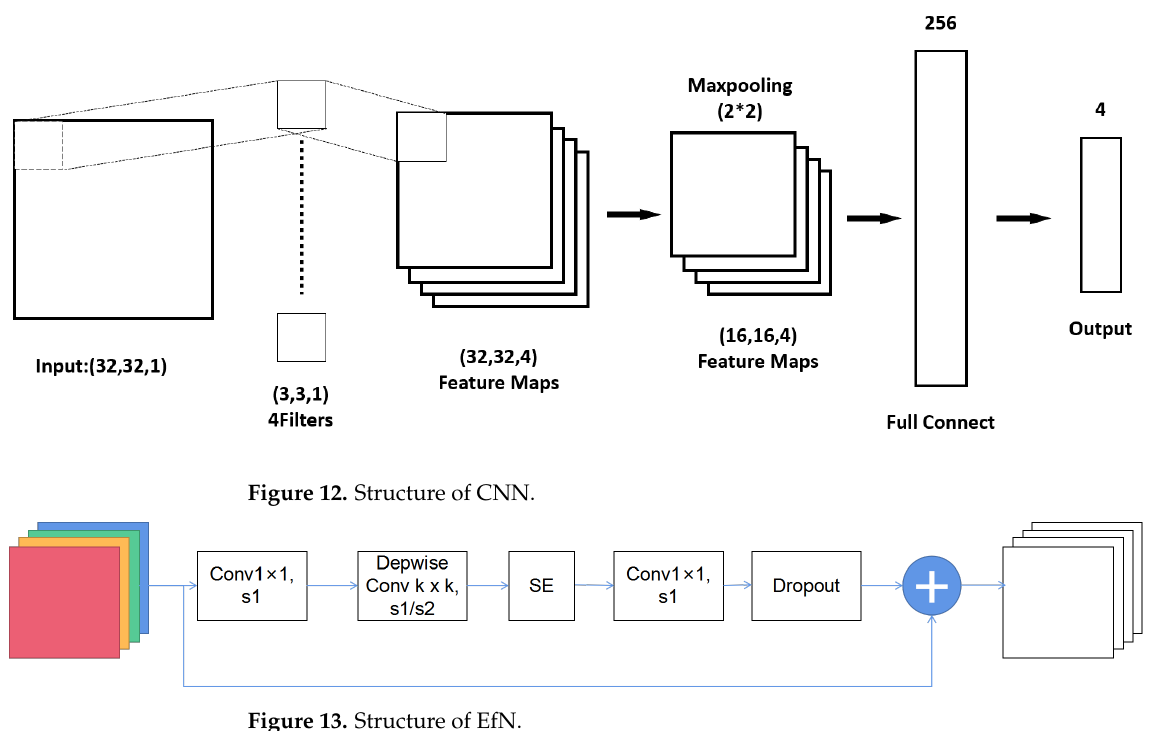
Figure 13. Structure of EfN.